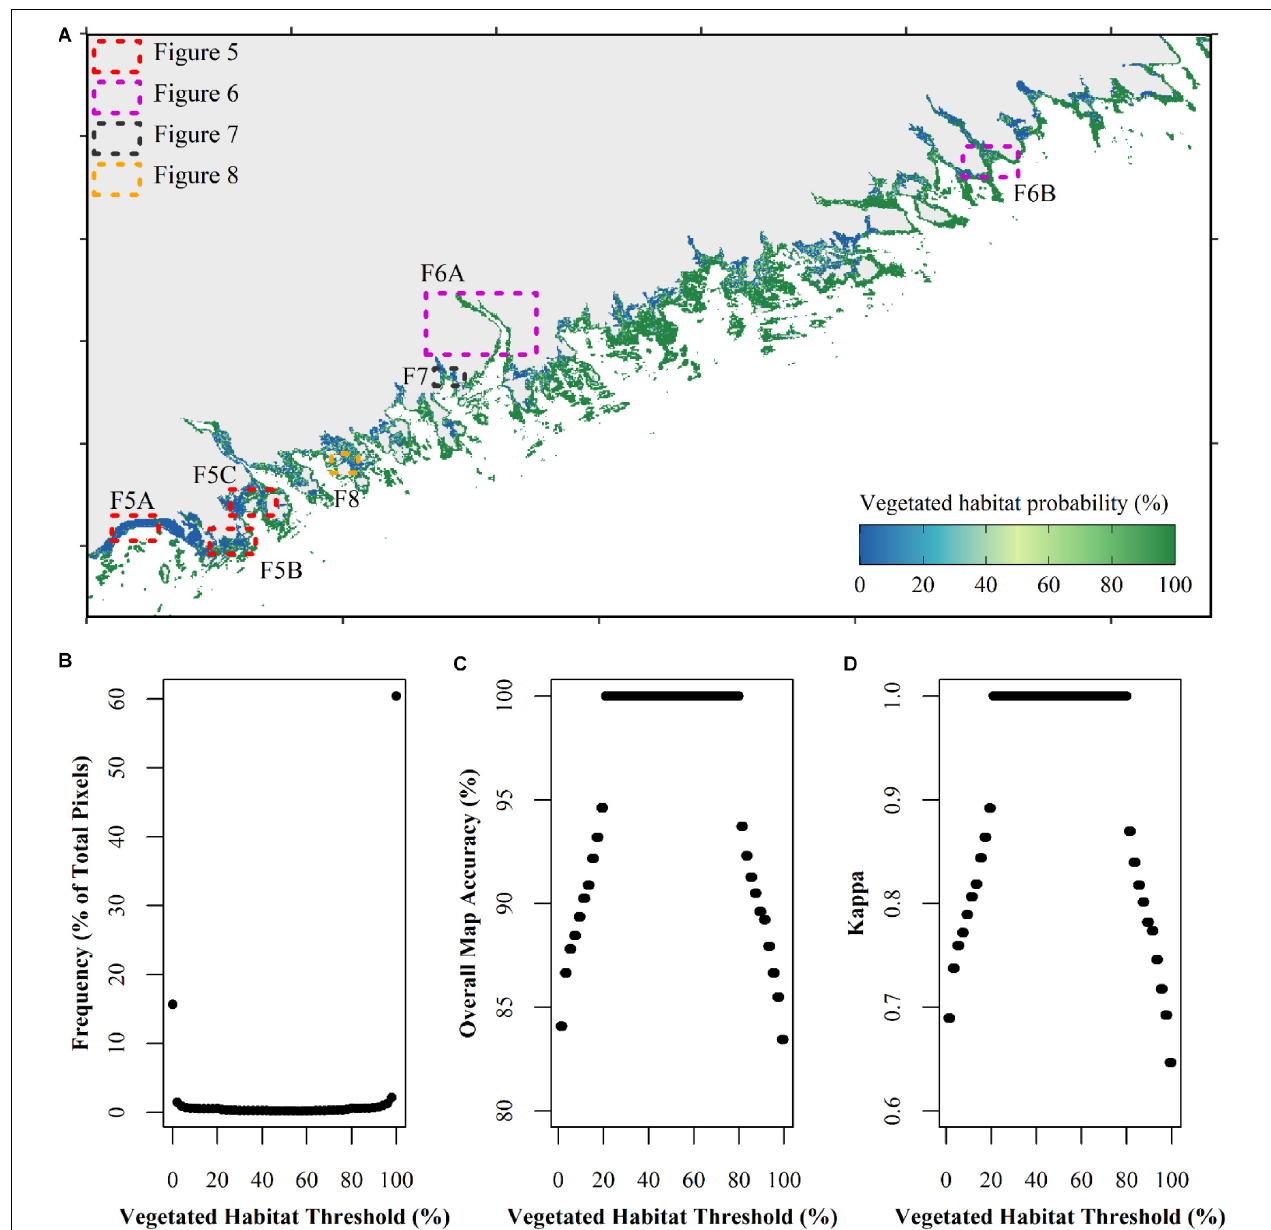
FIGURE 4 | Pre-threshold vegetation map demonstrating the probability that a pixel contains vegetated habitat with land (light gray) and deep water ( ≥ 10 m; white) masked (A) . Pixels classified as vegetated or non-vegetated with the threshold classification were labeled as 100 or 0%, respectively. All other pixels were classified with the random forests classifier and probability was determined as the number of times a pixel was classified as vegetated divided by 50. Polygons with dashed borders indicate the location of zoomed in boxes in the following figures. The number of pixels at each probability value (B) . The effect of various threshold choices for the map in (A) on overall map accuracy (C) and kappa value (D) using all data points (see Table 1